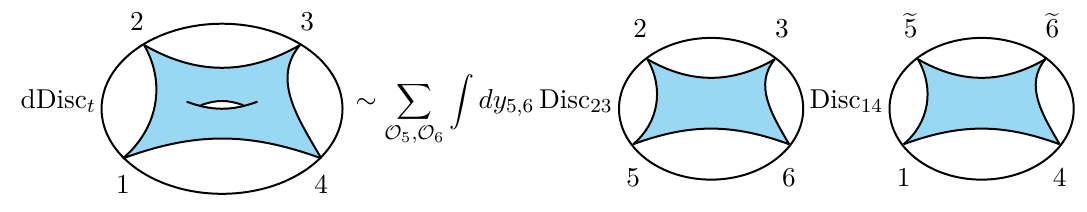
Figure 1 . In the Regge limit the dDisc of the genus one closed string amplitude in AdS is given by the perturbative CFT optical theorem in terms of genus zero